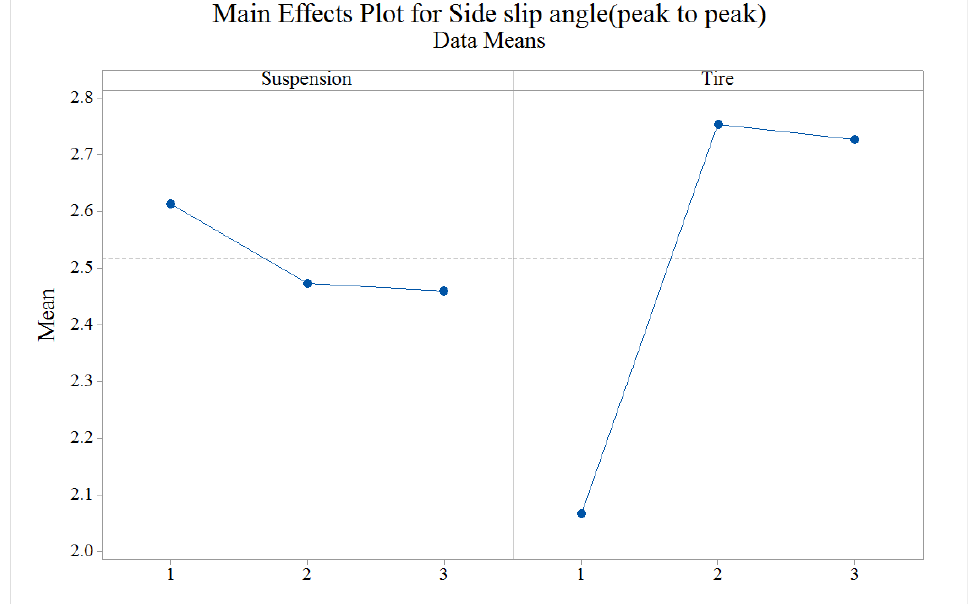
Figure 15. Suspension and tire test results (double-lane change; side-slip angle).